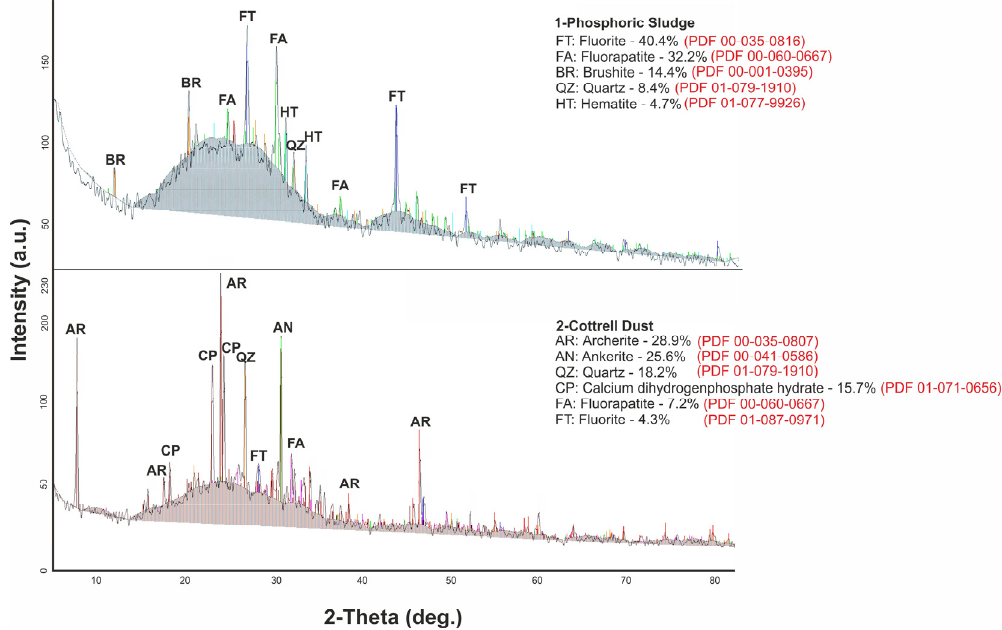
Figure 1. XRD patterns of phosphorus sludge and cottrel dust.